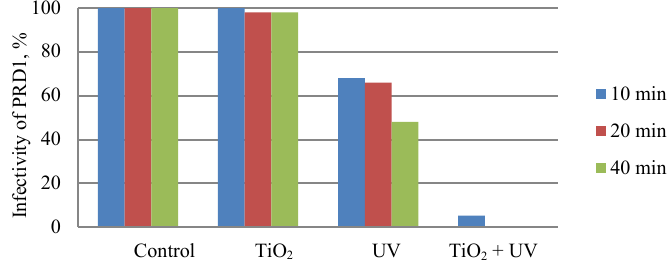
Fig. 2. Infectivity of bacteriophage PRD1. The experiments performed at 22 °C, the initial number of infective PRD1 particles was 1×10 4 pfu/mL, 1 mg/mL of TiO 2 and the intensity of UV irradiation 2 mW/cm 2 were applied. For experiments with bacteriophage mixtures, initial concentrations of PRD1 and T4 phages were the same – 1×10 4 pfu/mL. These phages have different hosts, and two different bacterial cultures were infected after the treatment: E. coli DH5α for determination of T4 infectivity, and S. enterica DS88 for determination of infectivity of PRD1. The maximum treatment time was 60